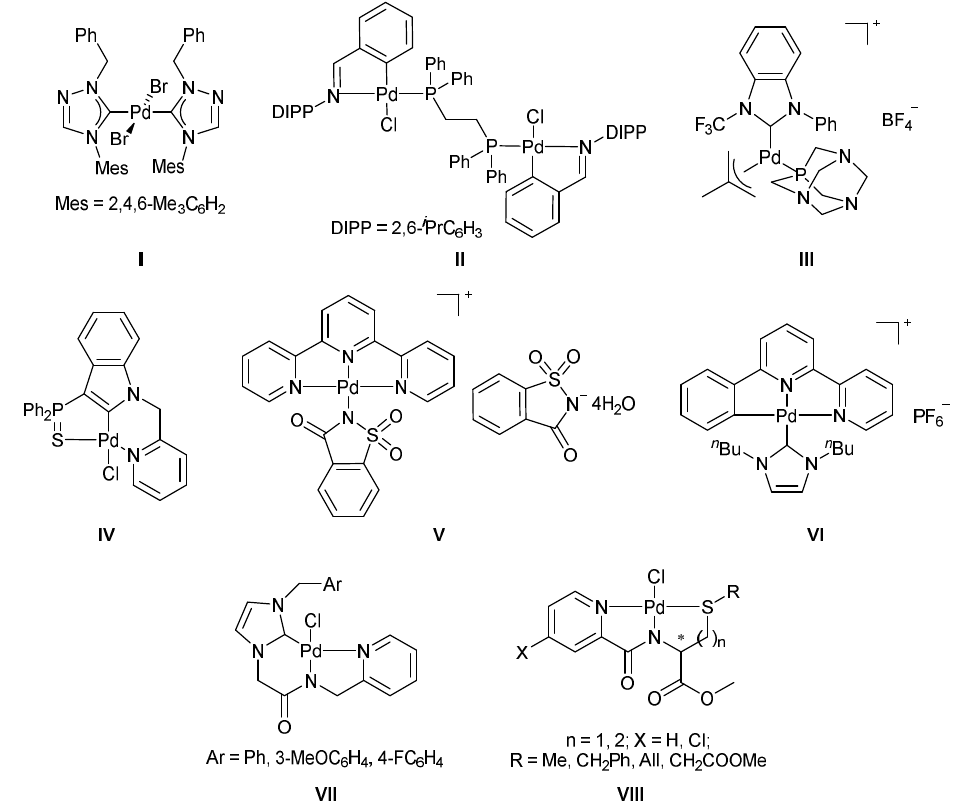
Figure 1. Selected examples of Pd(II) complexes exhibiting anticancer properties [24–32].